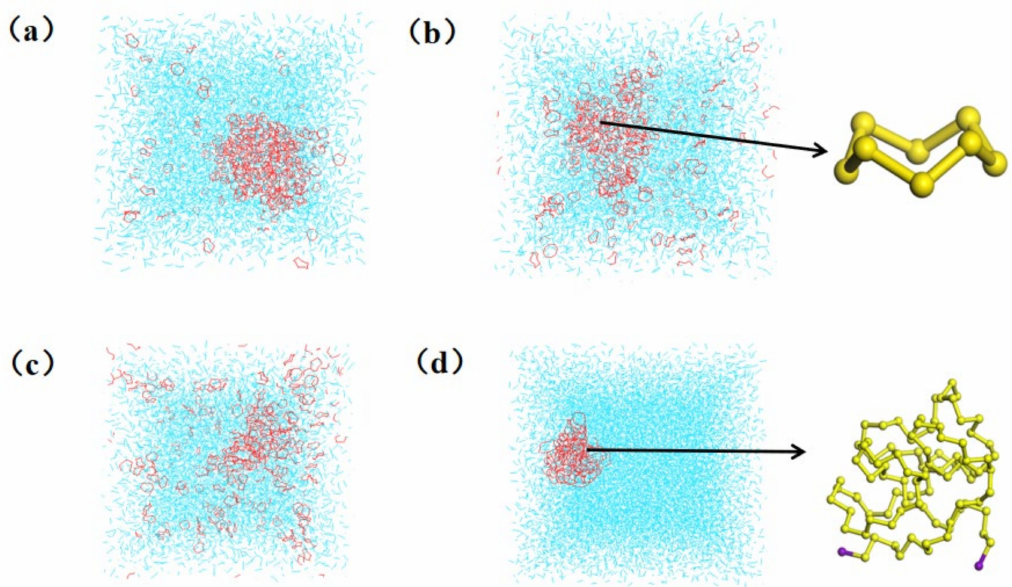
Figure 3. Each system of model A and B simulates the last frame conformation for ( a ) A-298 model, ( b ) A-318 model, ( c ) A-333 model, ( d ) B-333